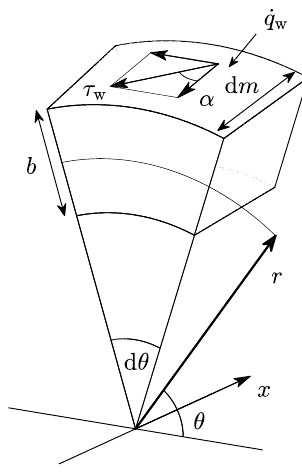
Figure 3. Differential control volume used to derive the diffuser governing